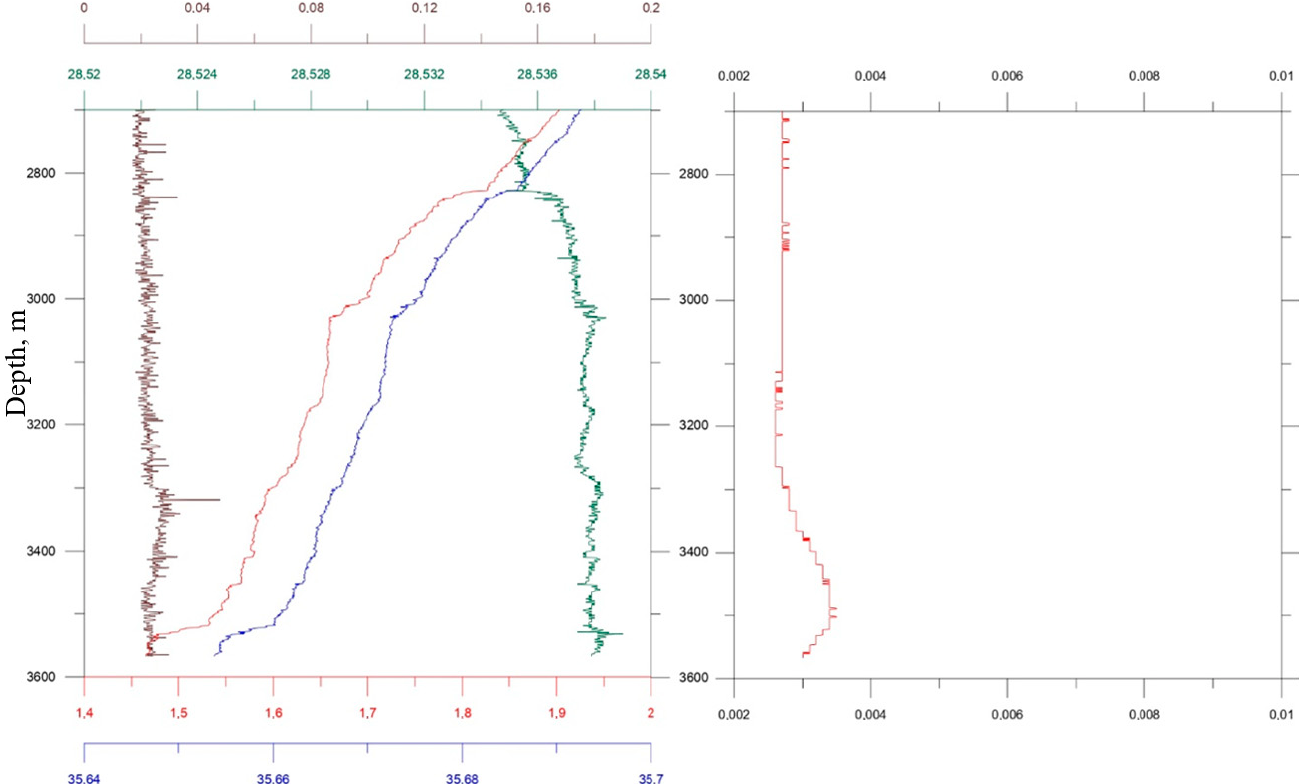
Figure 10. Results of CTD sounding at Molodezhnoye field. Left: brown—turbidity, FTU; blue—salinity, ‰; red—temperature, °C; green—density, kg/m 3 ; right graph: methane concentration, µmol/L.